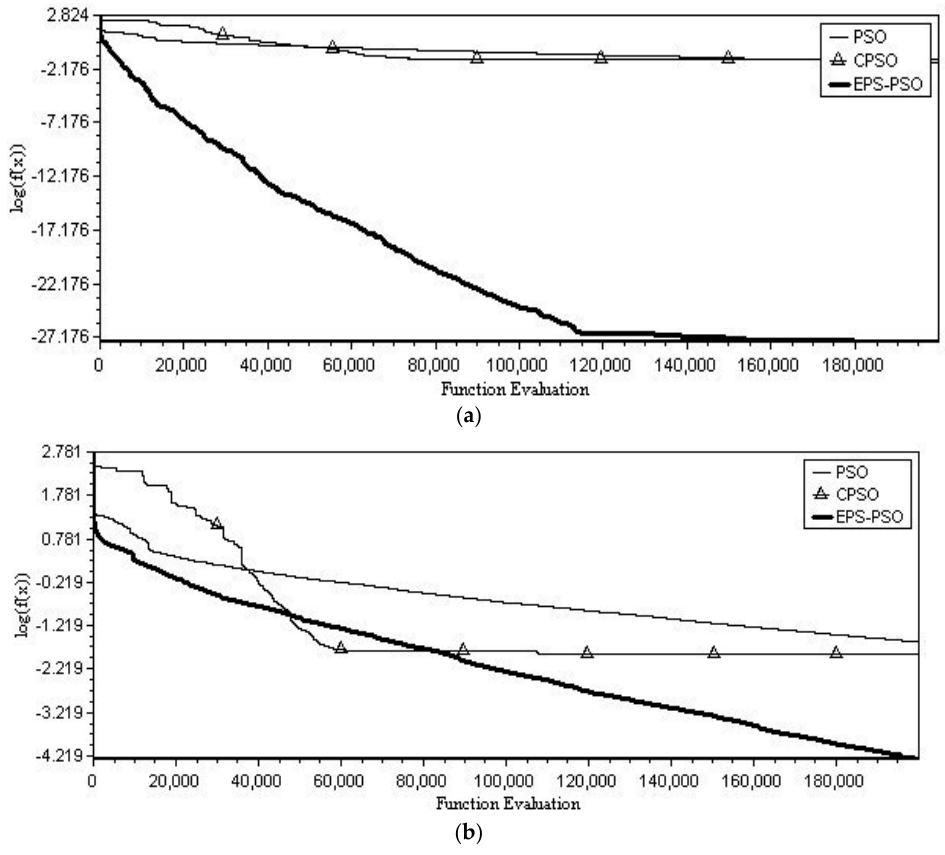
Figure 3. The best convergence results versus function evaluation among 50 independent runs for Rosenbrock ( 1 f ): ( a ) unrotated case, ( b ) rotated case.